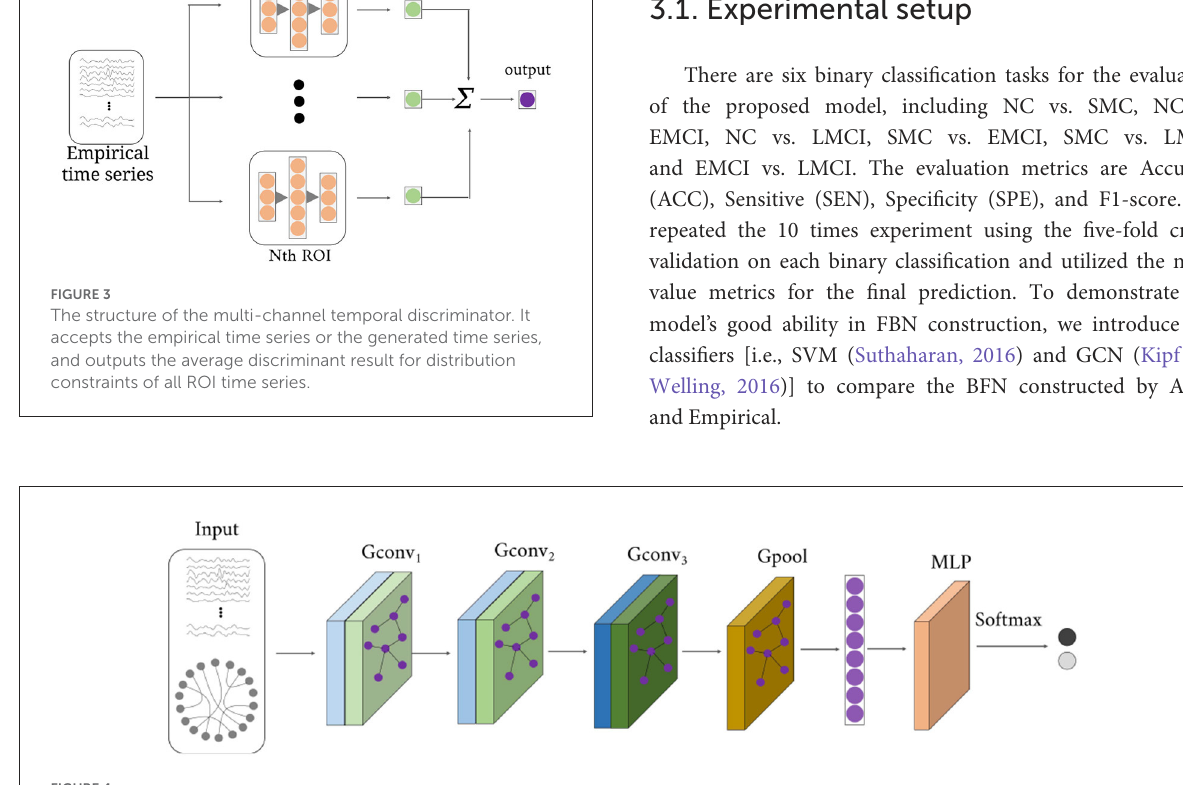
FIGURE4 The structure of the global-local connectivity